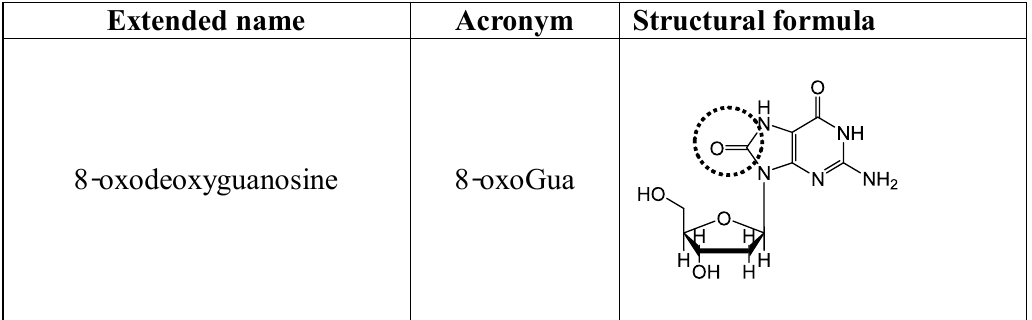
Figure 2. Major base lesions induced by